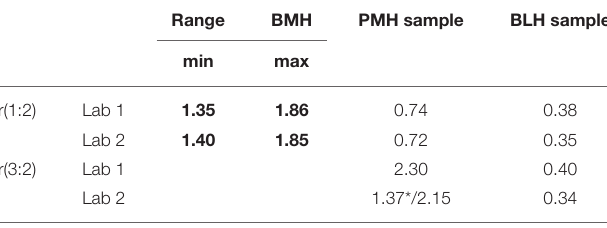
TABLE 2 | Range of signal intensity ratios calculated on 20 BMH samples by two laboratories. Range BMH PMH sample